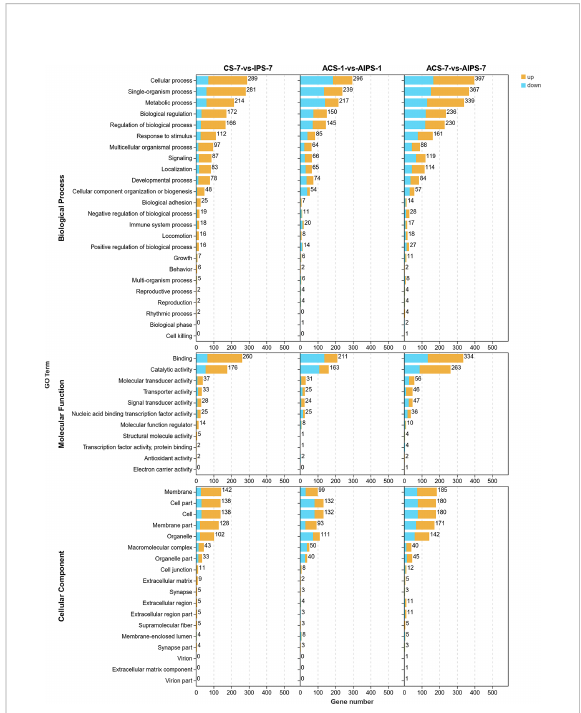
FIGURE 4 Gene ontology (GO) enrichment analysis of DEGs in the inactivated vaccine group compared to the PBS group at 7 th post immunization day and 1 st and 7 th post challenge day. 3-level GO annotations are distributed in three categories (biological process, molecular function and cellular component). Yellow represents up-regulated expression and blue represents down- regulated expression.